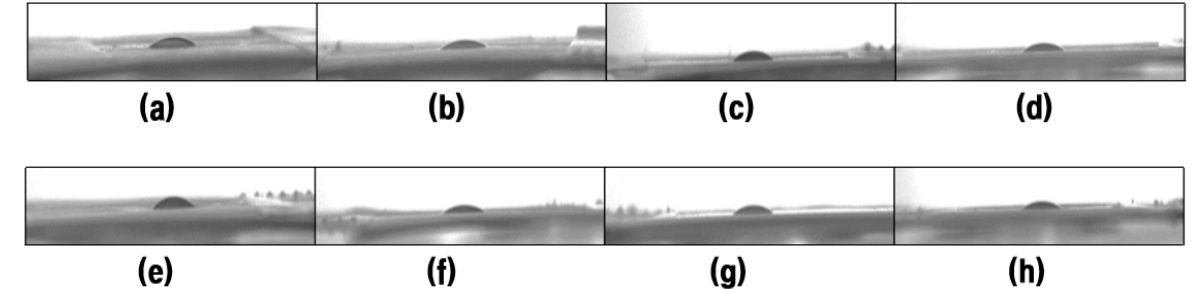
Figure 9. Optical micrographs of the new engine oil droplets; ( a – h ) represents the PVA solution concentration from 8% to 15%, respectively.